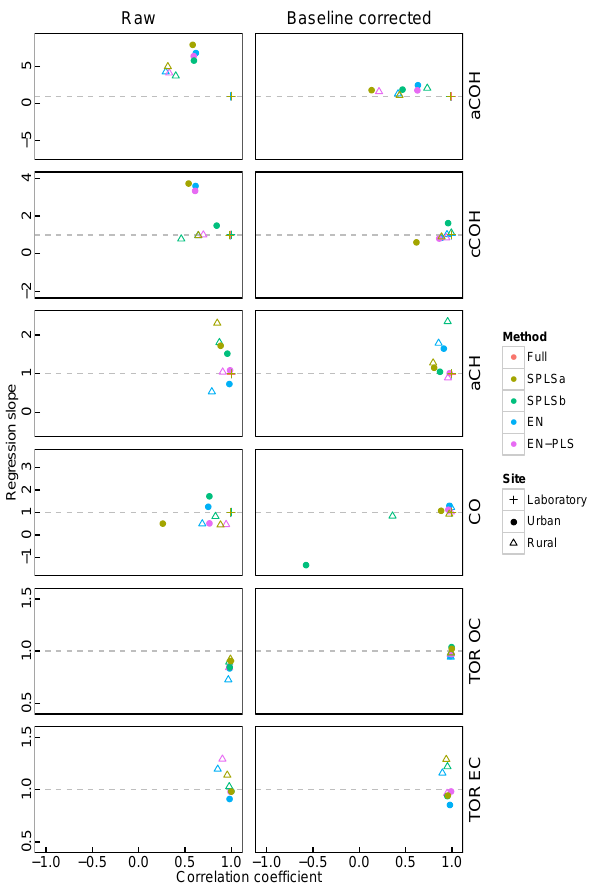
Figure 4. Comparison statistics of full and reduced wavenumber solutions show sensitivity of model predictions to sparsity. OC and EC correspond to predictions from direct calibration to TOR mea- surements rather than summing